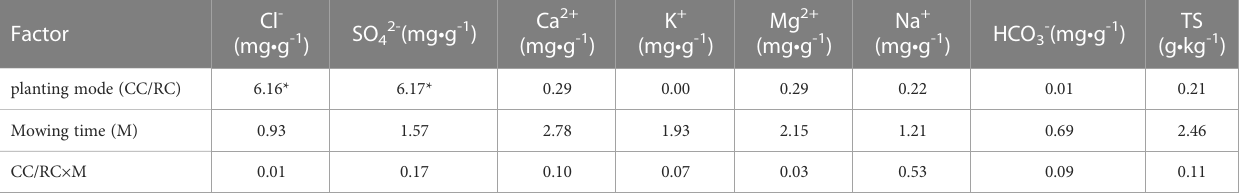
TABLE 4 Two-way ANOVA analysis of effects of the planting mode and mowing time on soil physicochemical